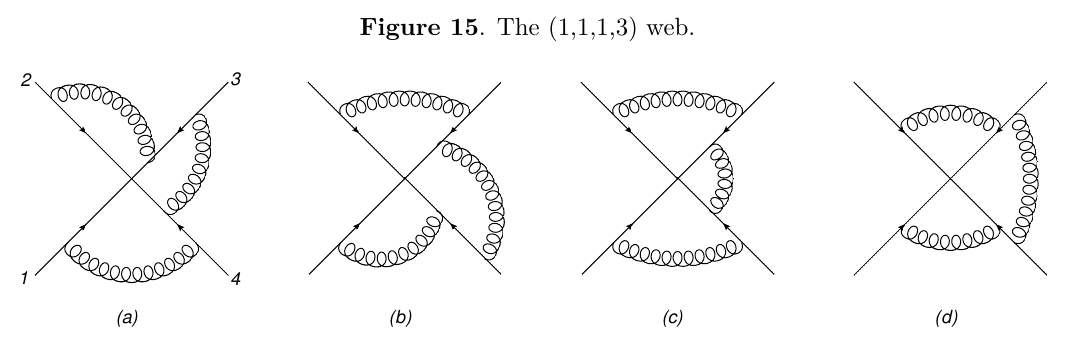
Figure 15 . The (1,1,1,3) web.